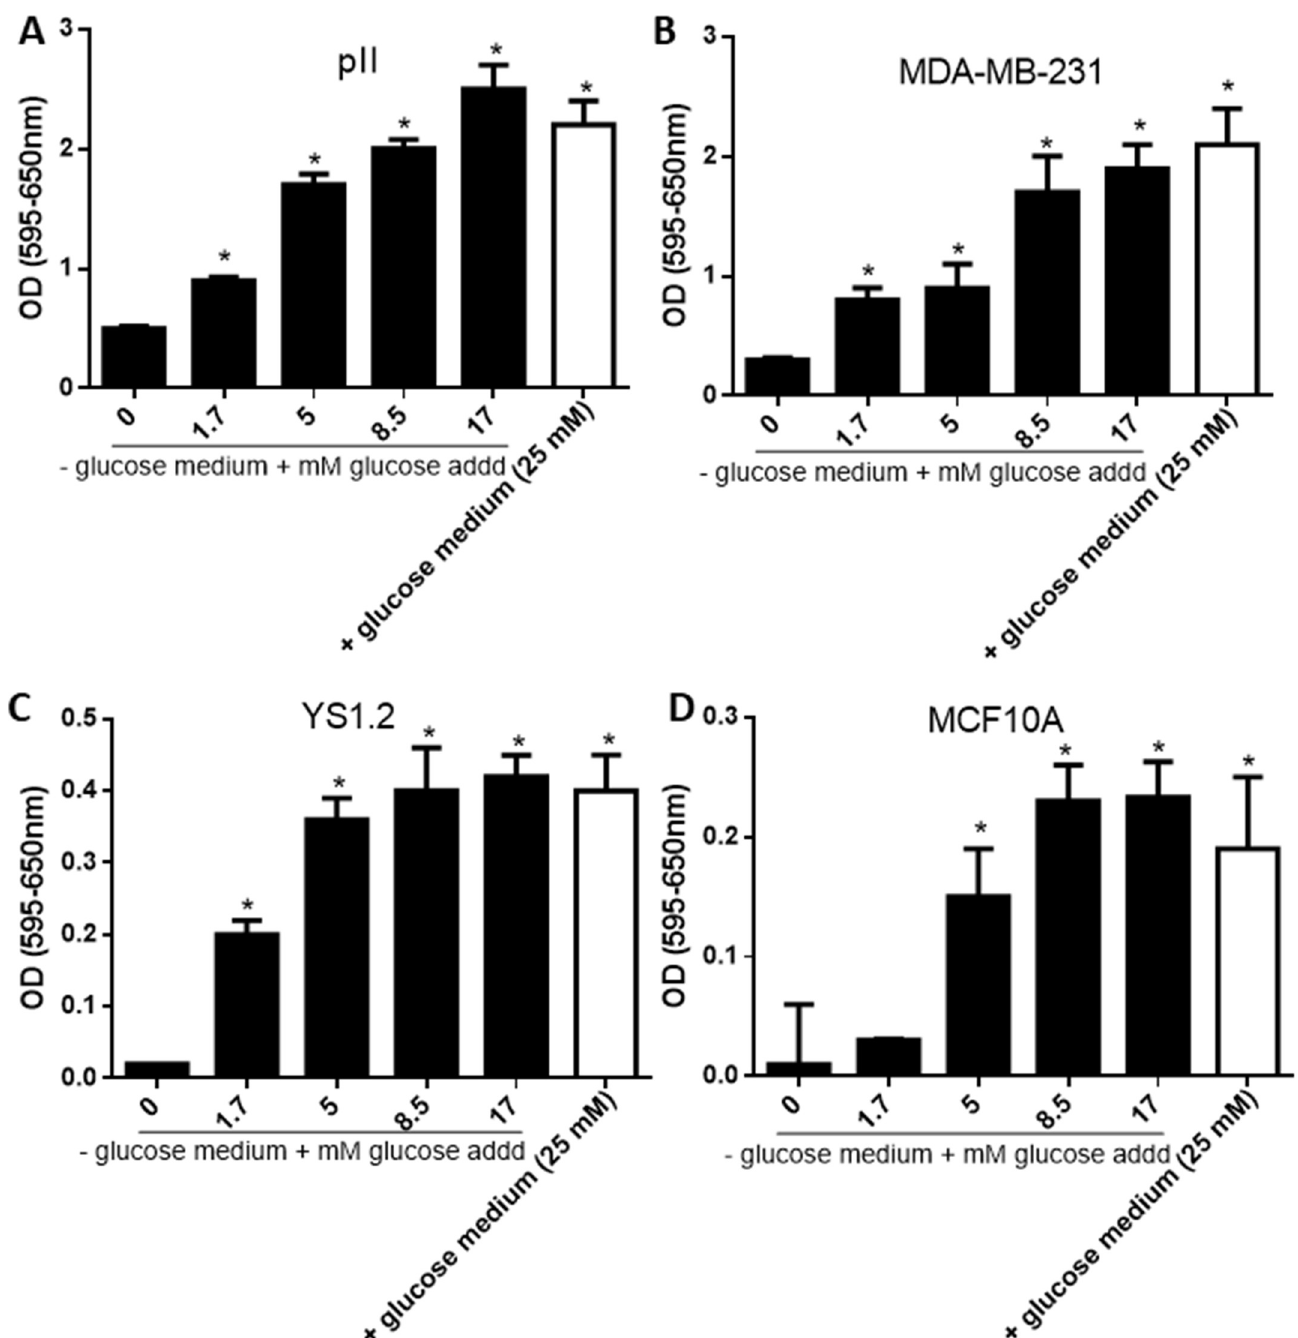
Fig 2. Effect of glucose concentration on breast cancer cell proliferation. Proliferation of pII (panel A), MDA-MB-231 (panel B), YS1.2 (panel C), and MCF10A (panel D) cells after culture for 4 days in + glucose medium (open bars) or–glucose medium supplemented with various concentrations of glucose as indicated (solid bars), was determined using the MTT assay. Histobars represent means ± SEM of at least 3 independent determinations. � denotes significant difference from cells cultured in—glucose medium, with p < 0.05. https://doi.org/10.1371/journal.pone.0272449.g002 containing glucose or to glucose-free medium containing 20 mM lactate, the cells regained their motility (panel B). Combined data from 3 independent experiments is given in panel C.